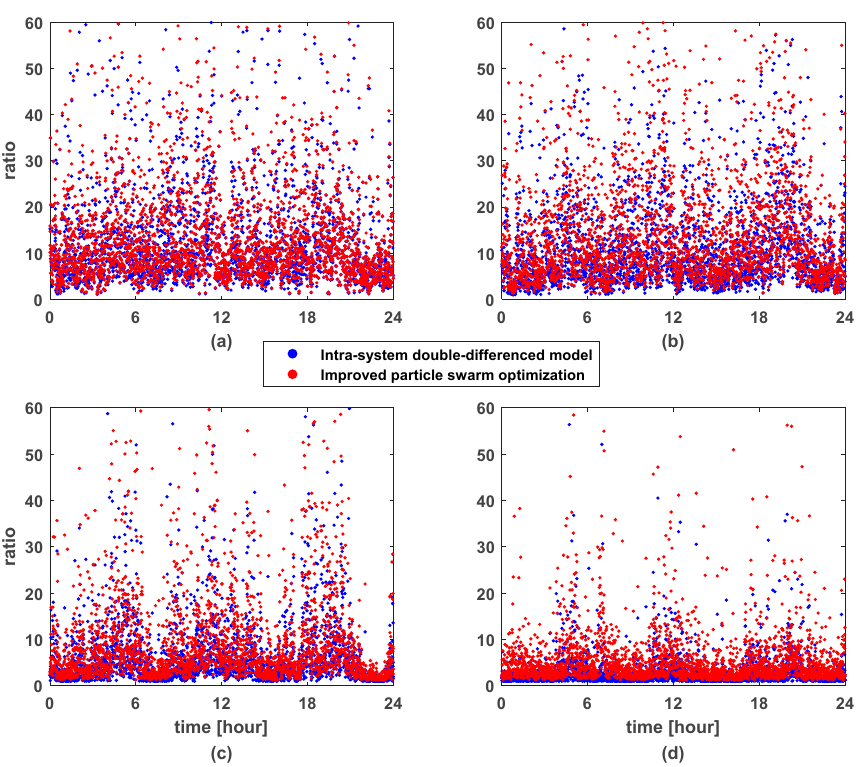
Figure 5. The distribution of ratio values at different cut-off elevation angles. ( a ) 15 degrees. ( b ) 25 degrees. ( c ) 35 degrees. ( d ) 45 degrees.